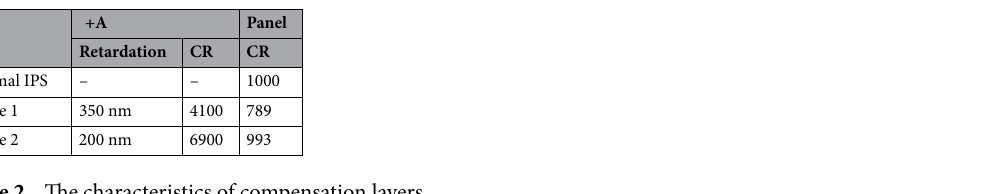
Table 2. The characteristics of compensation